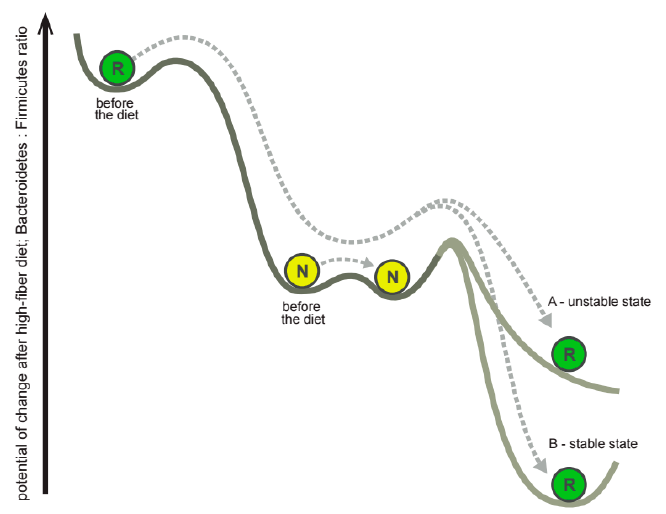
Figure 5. Gut microbiota momentum after the impact of the short-term diet. In the diagram describing the suggested effect, circles denote the location of community structures for typical responders (R) and non-responders (N) before and after the diet in the schematic landscape of possible microbiota configurations. Arrows represent the change of microbiota under the impact of diet.